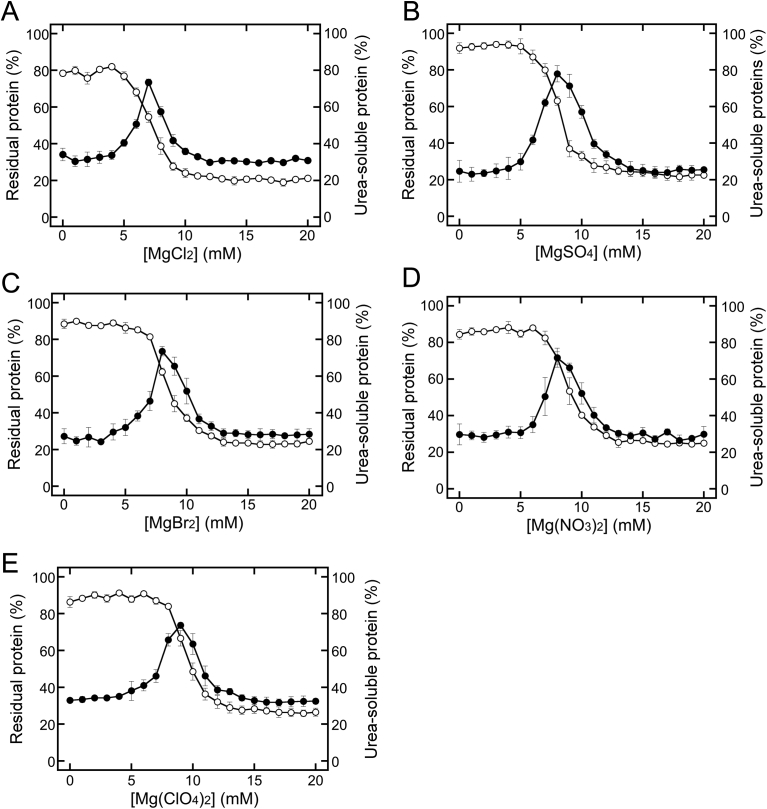
Changes in residual and urea-soluble proteins in the presence of various Mg salt solutions. MgCl2 (A), MgSO4 (B), MgBr2 (C), Mg(NO3)2 (D), and Mg(ClO4)2 (E) were added to soymilk at the indicated concentrations. Open and closed circles represent residual protein concentrations and urea-soluble protein concentrations, respectively. The data are shown as the averages ± standard deviations of three independent experiments.